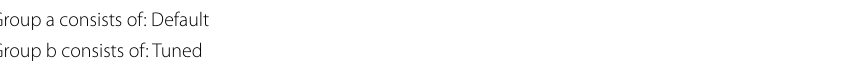
Table 15 HSD test groupings after ANOVA of AUPRC for the hyperparameters factor